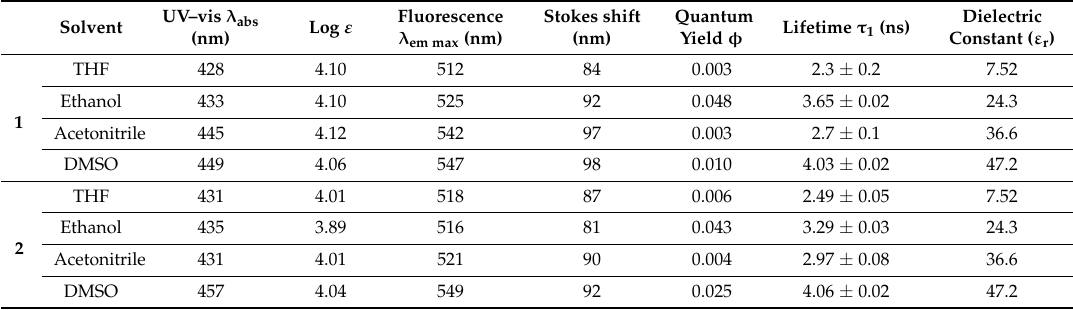
Table 1. UV–vis and fluorescence data for 1 and 2 (1 × 10 − 5 mol/L) in tetrahydrofuran (THF), ethanol, acetonitrile, and dimethylsulfoxide